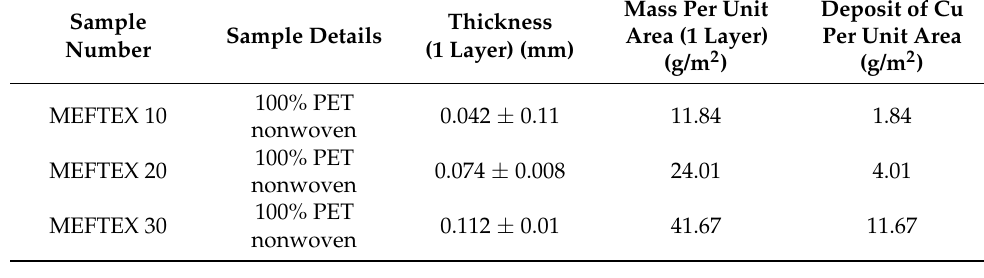
Table 1. Characteristics of the samples.